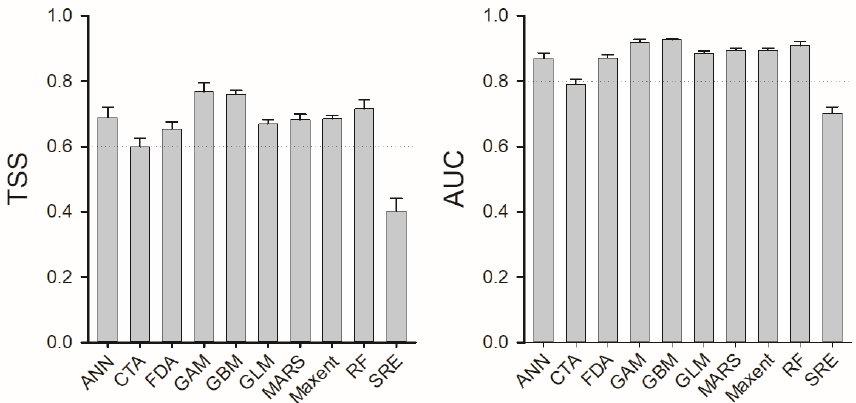
Figure 2. Ten modeling algorithms were evaluated for their predictive performance in estimating the habitat suitability of Paradoxornis heudei using the true skill statistics (TSS) and area under the receiver operating characteristic curve (AUC) metrics. ANN: artificial neural network; FDA: flexible discriminant analysis; GAM: generalized additive model; CTA: classification tree analysis; GBM: generalized boosted model; GLM: generalized linear model; SRE: one rectilinear envelope similar to BIOCLM; MARS: multivariate adaptive regression splines; Maxent: maximum entropy model; RF: random forest.